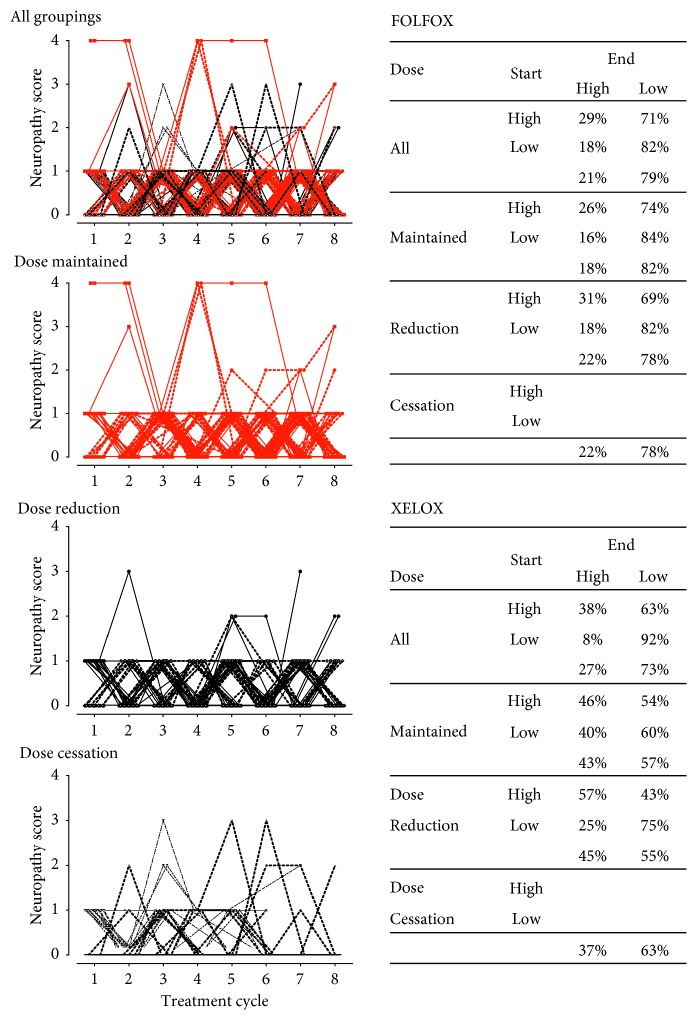
Cycle-by-cycle variance in neuropathic pain for individual patients on FOXFOX and XELOX treatment regimens. In the left hand panels subject-by-subject neuropathy scores for those receiving FOLFOX were plotted and categorized based on the presence (≥1, solid line) and absence (<1 dotted line) of neuropathy in cycle 1 (n = 200). In the lower 3 panels, the data were grouped based on whether the FOLFOX regimen was maintained (n = 81), reduced (n = 57), or ceased (n = 49). The right hand panel tabulates the impact of the presence or absence of neuropathy in cycle one on the neuropathy scores at cycle 8 (end) of FOLFOX and XELOX treatments. The presence of patient-by-patient oscillations in the neuropathic score indicates that the emergence of neuropathy in one cycle is not predictive of the developing a higher score in the subsequent cycles. This observation held true across FOLFOX and XELOX even when regimens were subject to dose reduction and/or cessation indicating that neuropathic pain alone is not a sufficient reason to cease treatment.